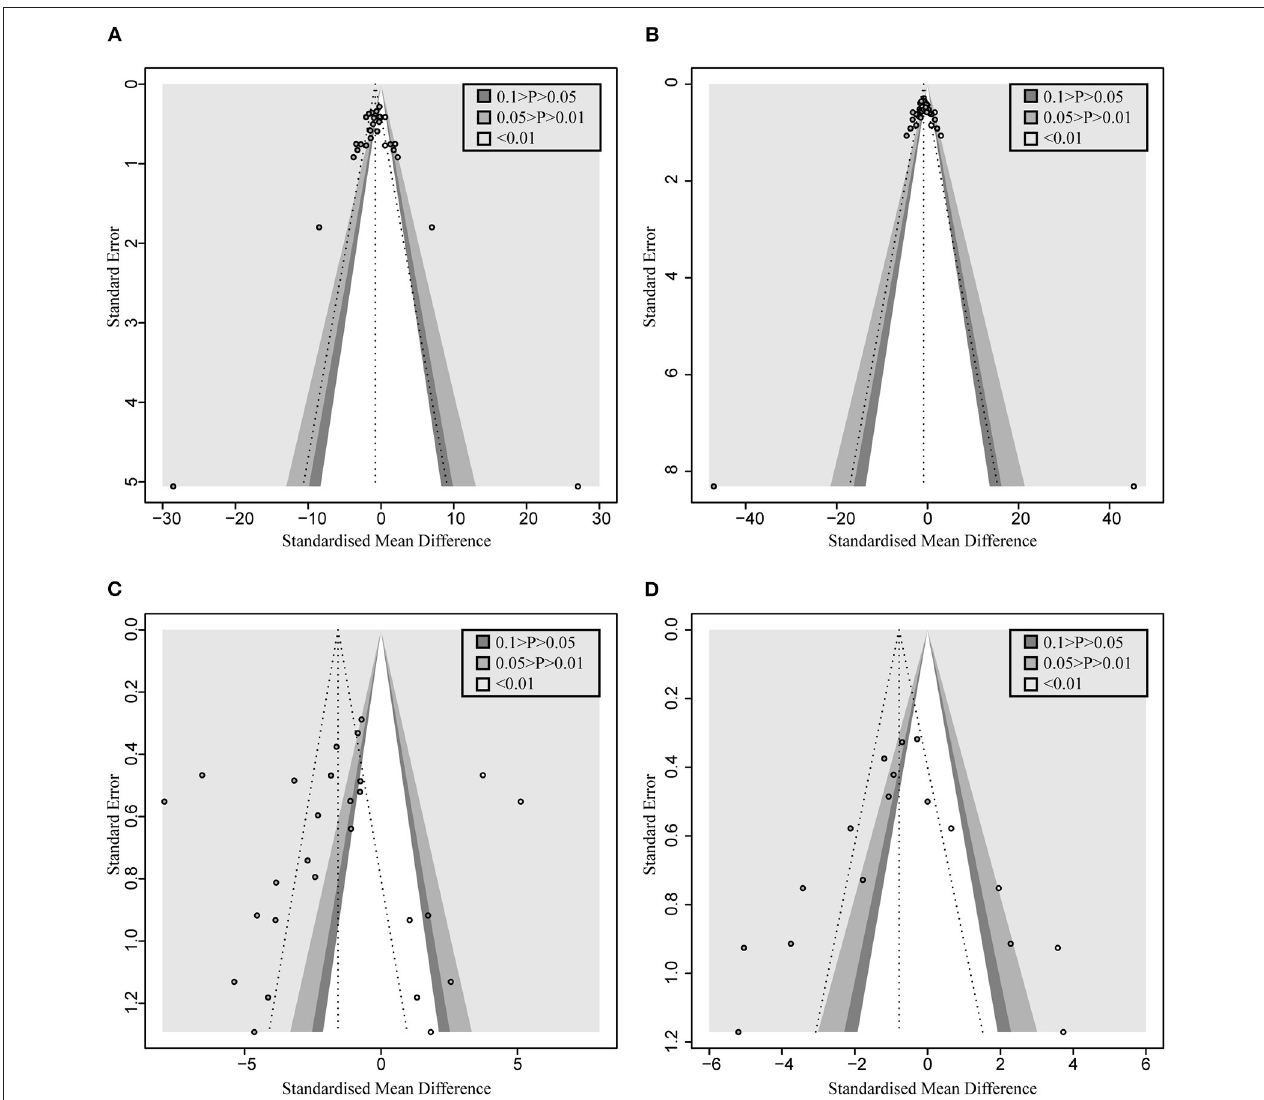
FIGURE 3 | Contour-enhanced funnel plot with trim-and-fill method. (A) AST. (B) ALT. (C) TNF- α (D) MDA. If the missing studies were in the nonsignificant area, the asymmetry was due to publication bias. Otherwise, the observed asymmetry could be attributed to factors other than publication